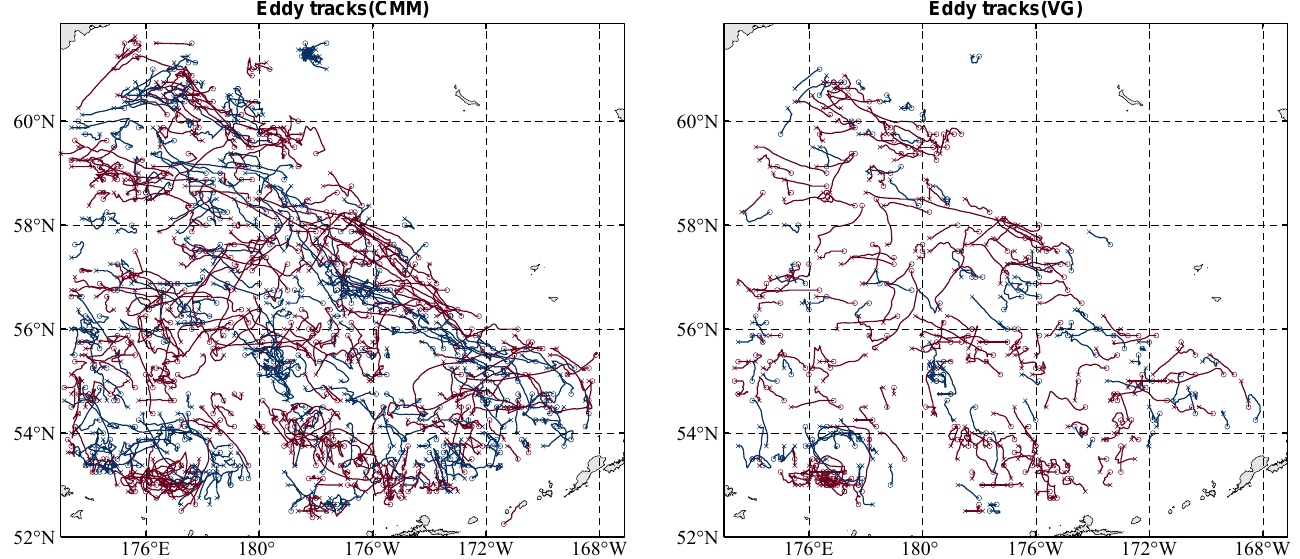
Figure 7. Eddy trajectories (for eddies with a lifetime of >4 weeks); red lines are trajectories of cyclonic eddies and blue lines are trajectories of anticyclonic eddies; the hollow circles indicate the starting positions of an eddy track, and the forks indicate the ending positions. The left panel is the eddy trajectory distribution of the CMM method. The right panel is the eddy trajectory distribution of the VG